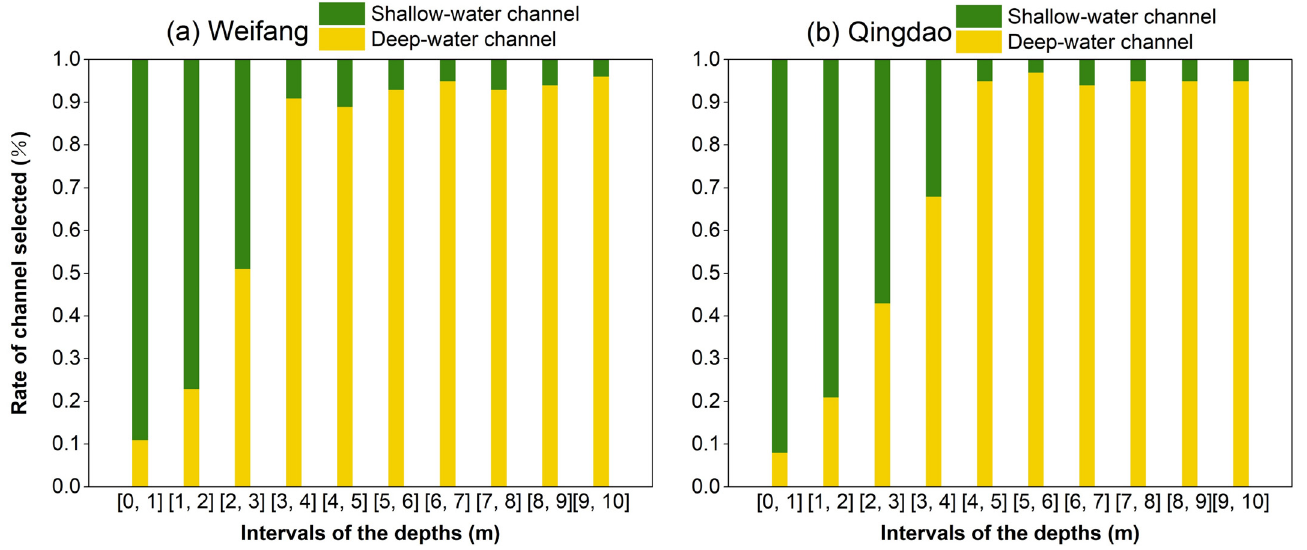
Figure 10. Channel selection ratios at various water depths for the test fields at ( a ) Weifang and ( b ) Qingdao.